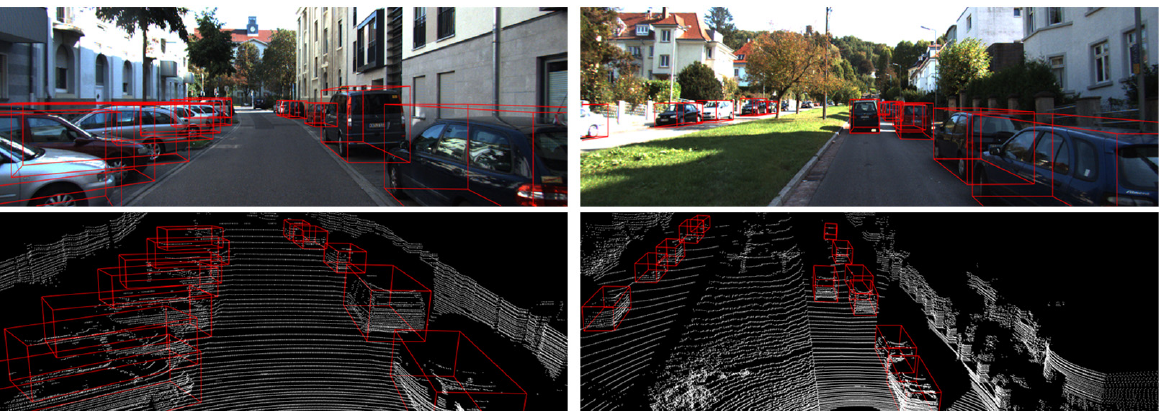
Figure 9. A visualization result of cars using the KITTI test set. The detection results are indicated by a red box.